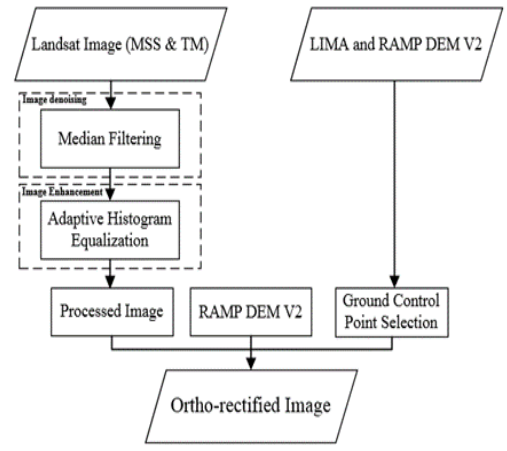
Figure 1. Flowchart of the proposed Landsat image